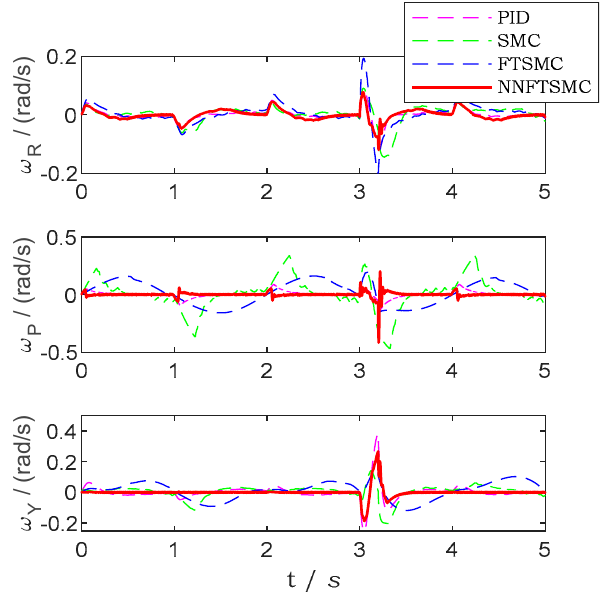
Figure 15. The angular velocity of the platform by using different controllers in the simulation of